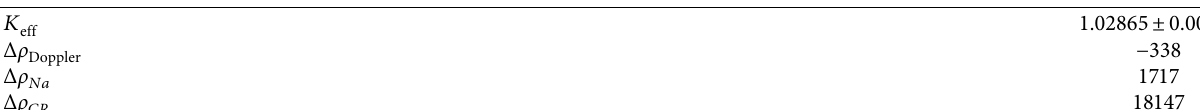
Table 5: Results of MET-1000 after coupling.